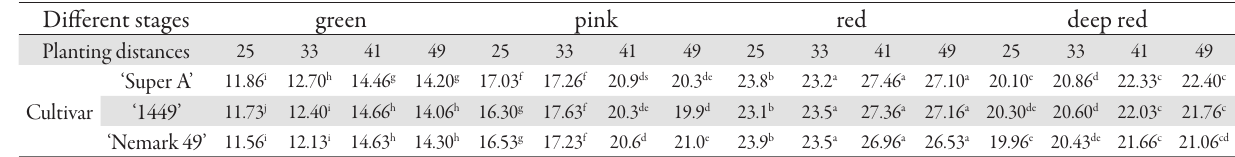
Means with similar letters in each column are not significantly different by LSD multiple range test ( p < 0.05) Tab. 3. Comparison of interaction between variety, row spacing and different stages of maturity for B-carotene Different stages green pink red deep red Planting